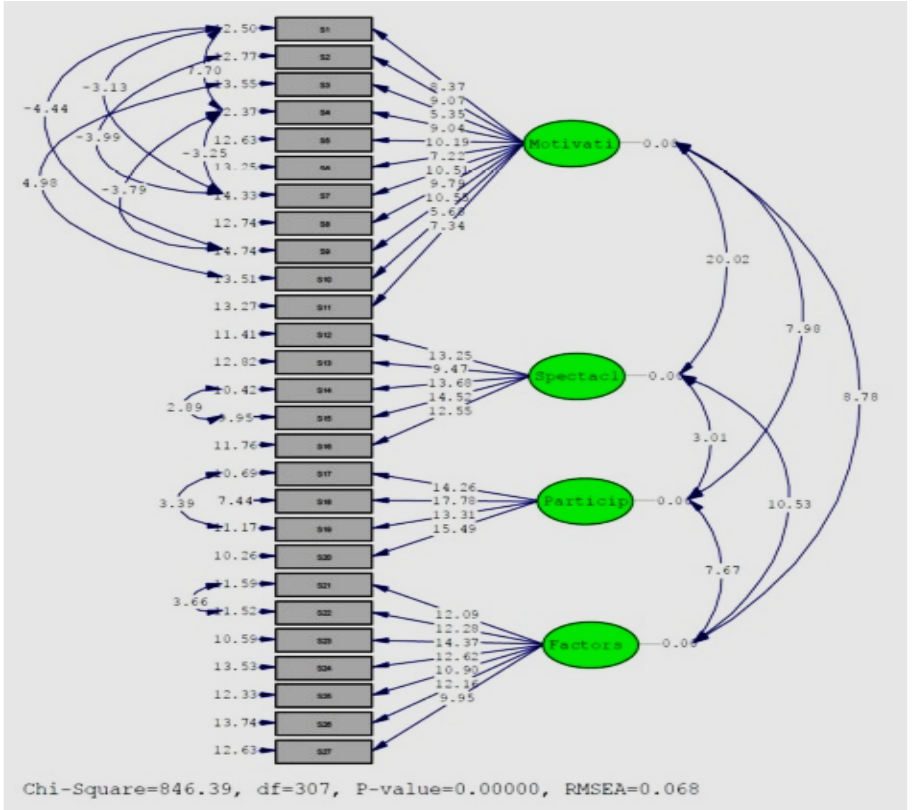
Figure 2. The t values of confirmatory factor analysis for the main study